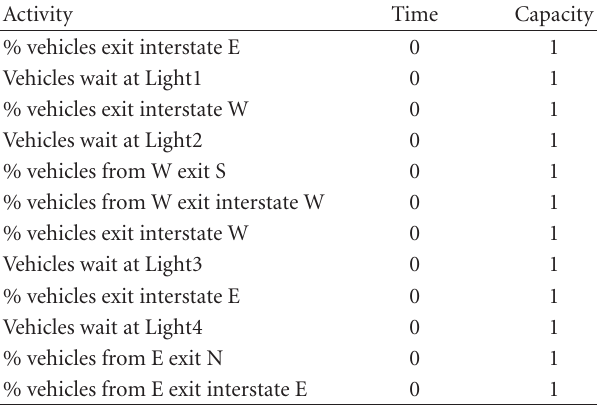
Table 4: Experimental